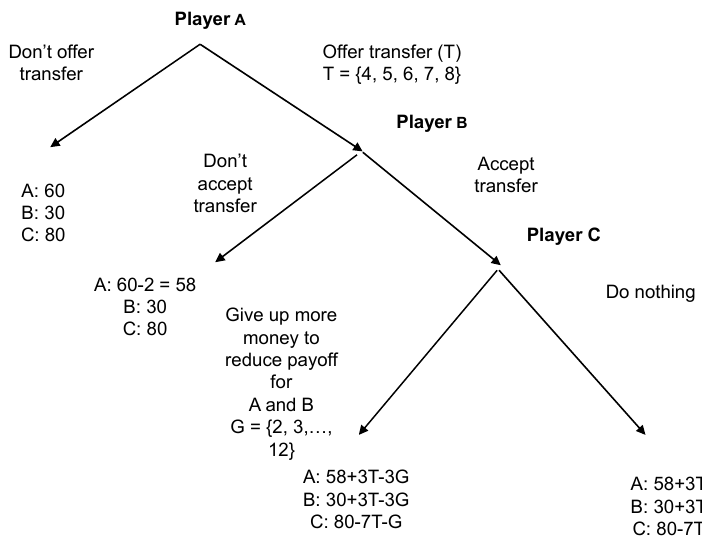
Figure 2. Structure of the experiment with neutral language.